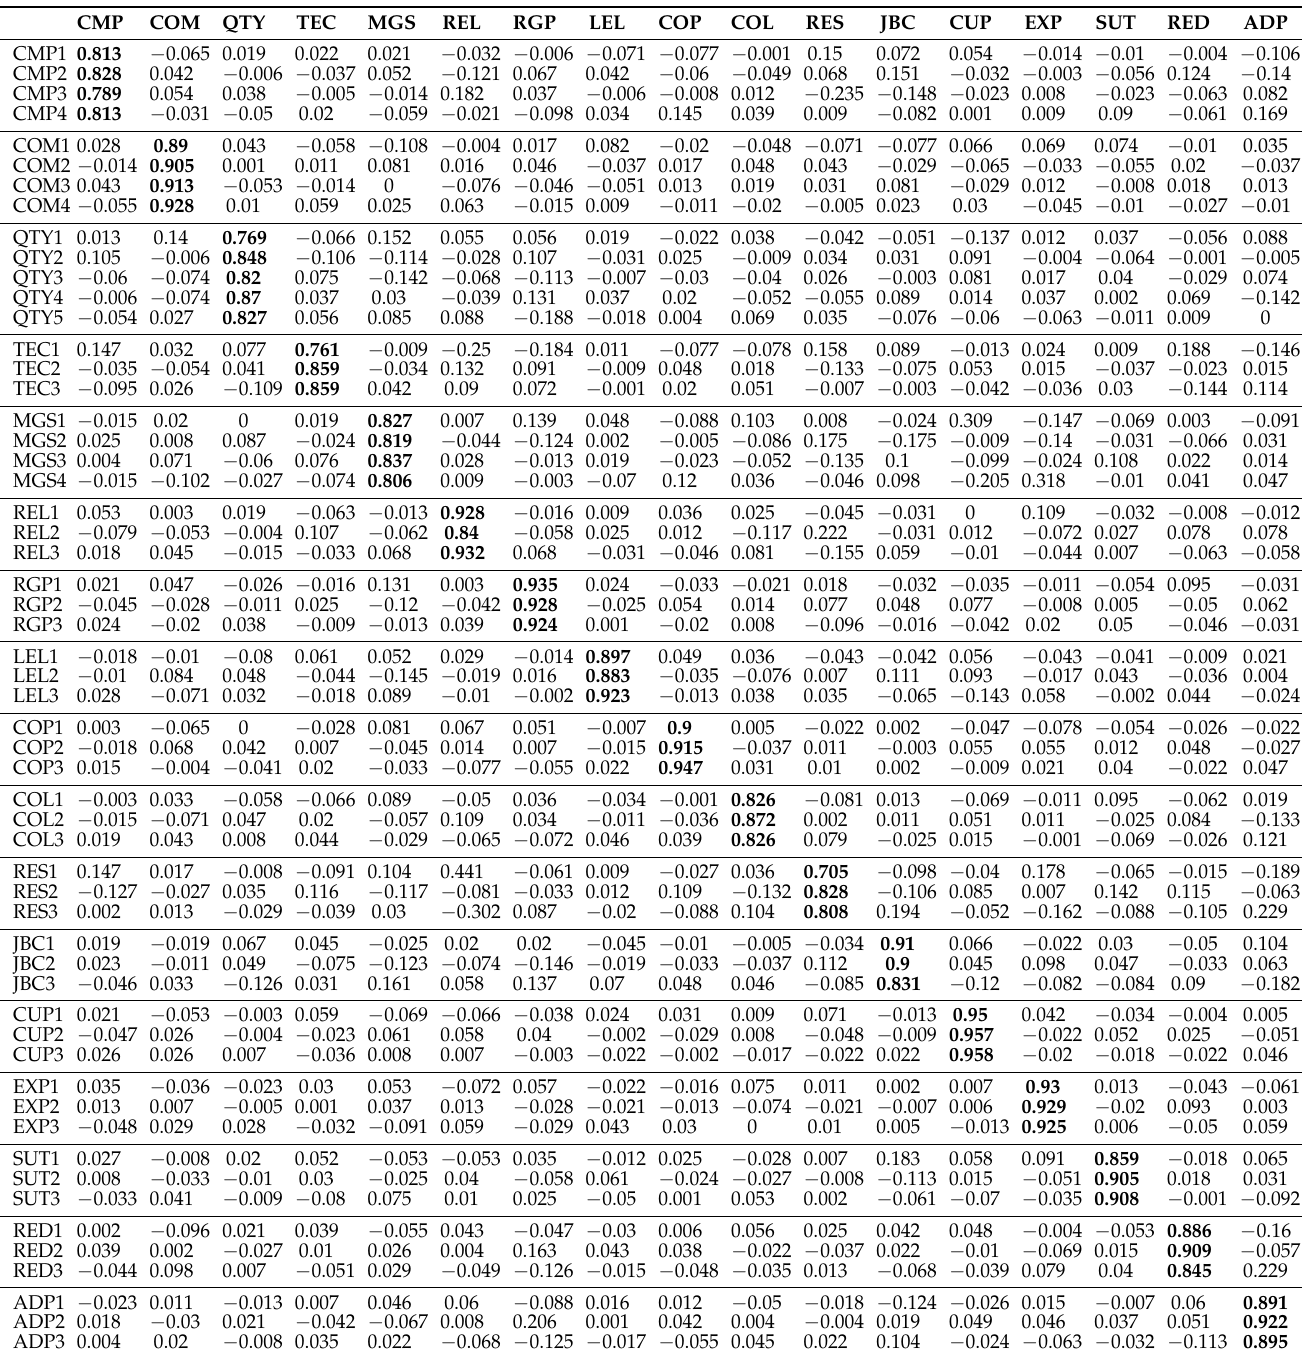
Table 3. Results of factor loading of